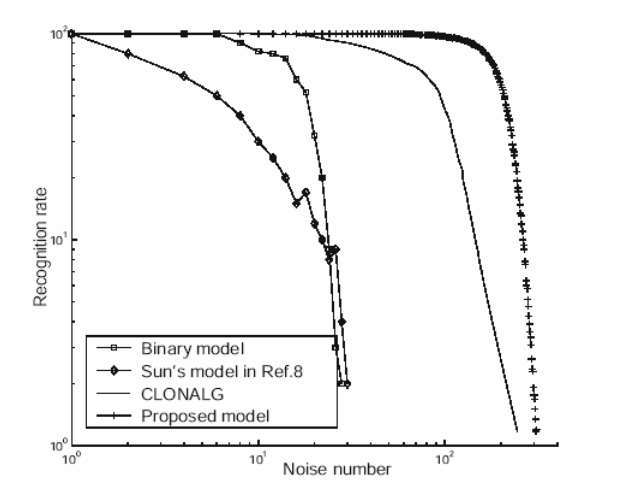
Figure 8. Recognition results of different AIS